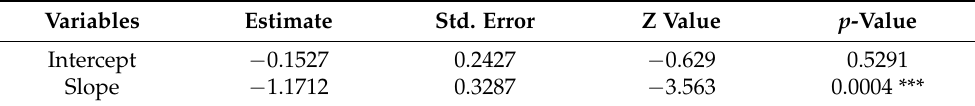
Table 9. Results of the logistic regression model predicting tropical dry forest gain using slope as a predictive variable. ‘***’ Significant at 0.001 level.